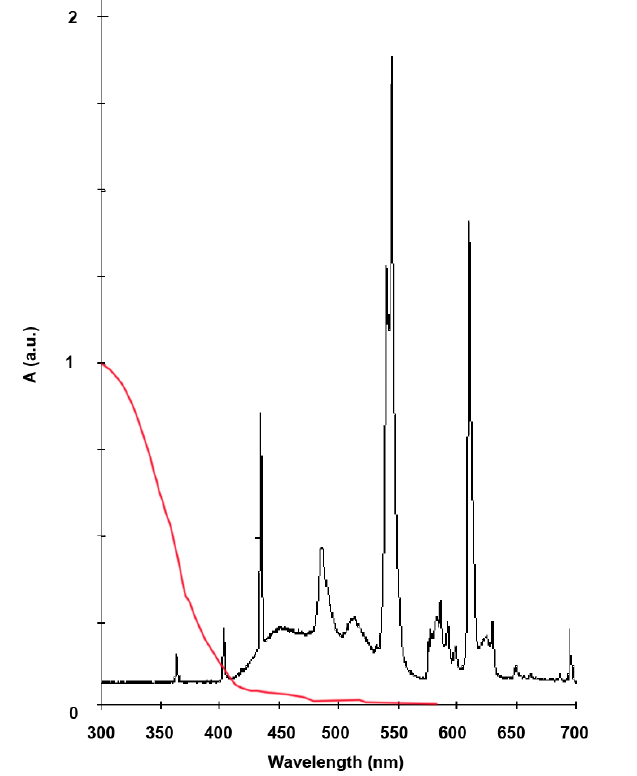
Figure 3. The solid-state diffusion-reflectance UV-Vis spectrum of Aeroxide ® TiO (in red), and the UV-Vis emission spectrum of fluorescent light at 6500 K